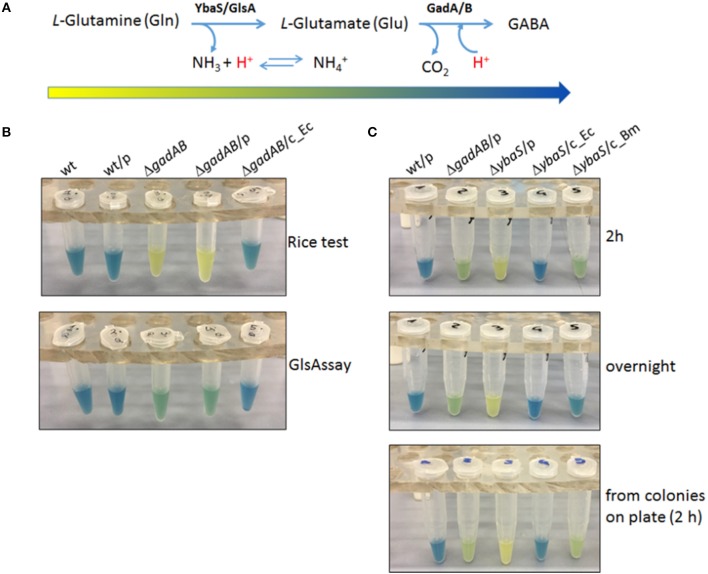
The GlsAssay in Escherichia coli K12 MG1655. (A) Working hypothesis of the GlsAssay based on the substrates and the enzymes involved. The arrow that begins yellow and ends blue corresponds to the approximate change in color that is expected to occur as the GlsAssay develops, using Gln as starting molecule. (B) Preliminary controls. Comparison between the Rice test performed using glutamic acid (upper panel) and the GlsAssay performed using glutamine (lower panel). The strains used were: E. coli wild type (wt); wt/pBBR (wt/p); ΔgadA-ΔgadB (ΔgadAB); ΔgadA-Δgad/pBBR (ΔgadAB/p); ΔgadA-Δgad/pBBR_gadBC (ΔgadAB/c_Ec). The presence of the empty plasmid pBBR1MCS (p) had no effect on the outcome of both tests. The strains were grown for 24 h in LBG pH 5.0, typically used for AR2 assay and Rice test in E. coli (Occhialini et al., 2012; Damiano et al., 2015). The GlsAssay was carried out at 37°C overnight. (C) Optimized conditions of GlsAssay as described in Materials and Methods (section Rapid Glutaminase Assay (“GlsAssay”) and in Figure S2). The assay was carried out on the strains: wt/pBBR (wt/p); ΔgadA-ΔgadB/pBBR (ΔgadAB/p); ΔybaS/pBBR (ΔybaS/p); ΔybaS/pBBR-ybaS_Ec (ΔybaS/c_Ec); ΔybaS/pBBR-glsA_Bm (ΔybaS/c_Bm). The incubation time is shown on the right. p, plasmid pBBR1MCS; c, complemented strain with the missing gene.